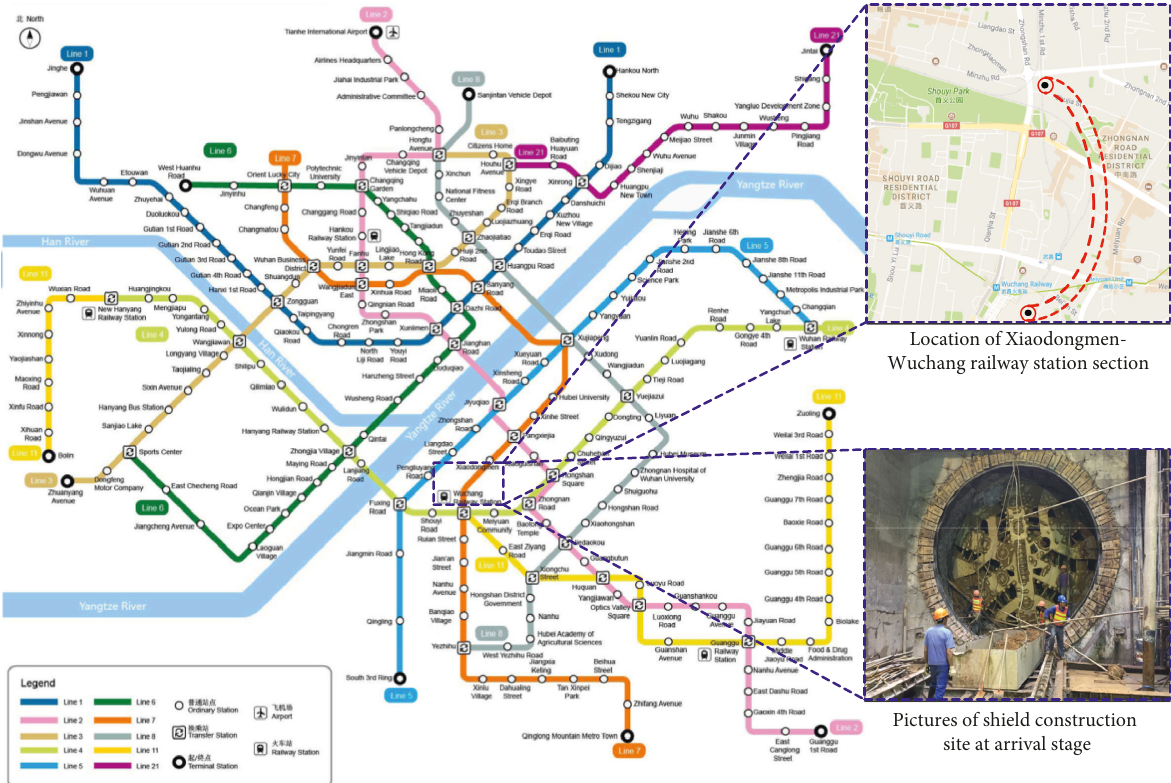
Figure 1: Location of the XW section in the Wuhan Metro